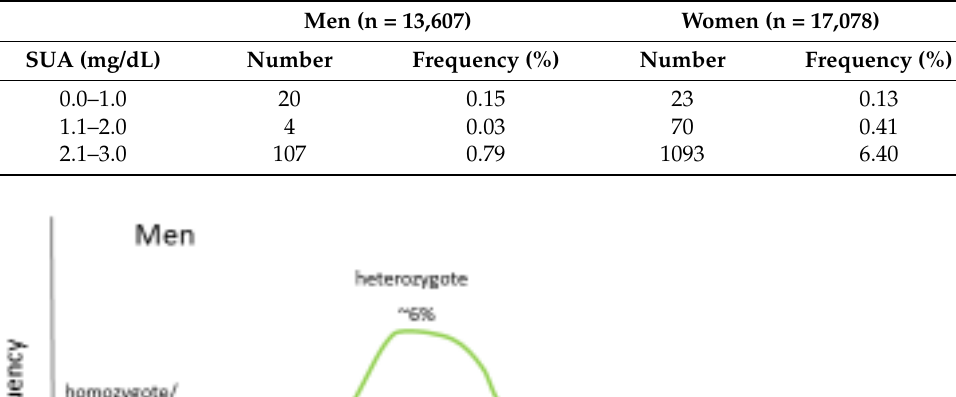
Table 2. Frequency of mutant URAT1 alleles (W258X and R90H) in individuals with low SUA con- centrations [11].